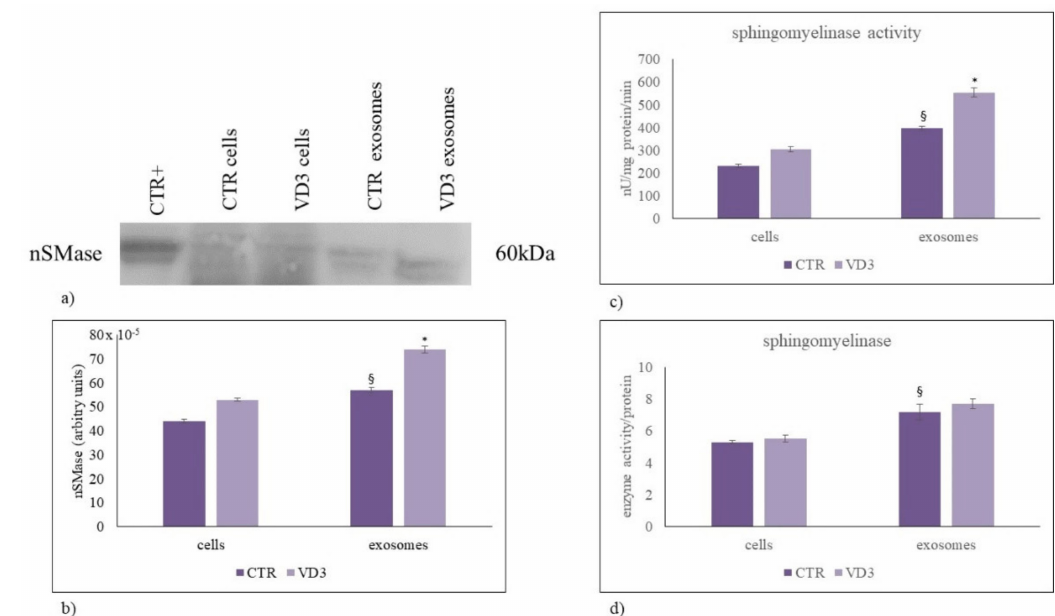
Figure 6. Neutral sphingomyelinase in cells and exosomes. ( a ) Immunoblotting analysis. The position of the 60 kDa was evaluated in relation to the molecular-weight size markers. HaCaT cells were used as positive control [19]; ( b ) The area density was quantified by Chemidoc Imagequant LAS500 by specific IQ programm. ( c ) Enzymatic activity of neutral sphingomyelinase. Data are expressed as nU/mg protein/min; ( d ) Neutral sphingomyelinase activity in relation to enzyme content. Data represent the mean ± SD of three independent experiments performed in duplicate (case number: 6). * p < 0.05 versus the control sample, § p < 0.05 versus cells, CTR, control sample; VD3, vitamin D3 sample.